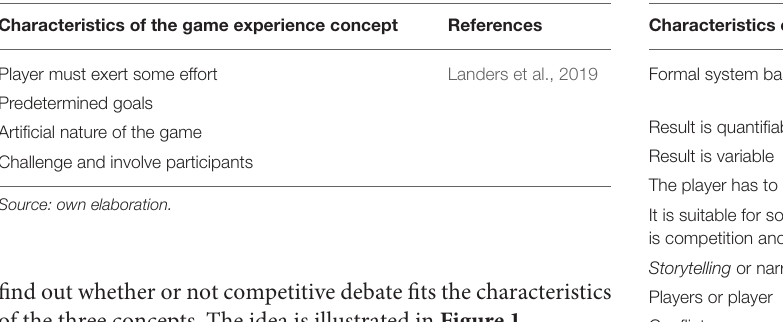
TABLE 1 | Characteristics of the concept game experience. TABLE 2 | Characteristics of the game